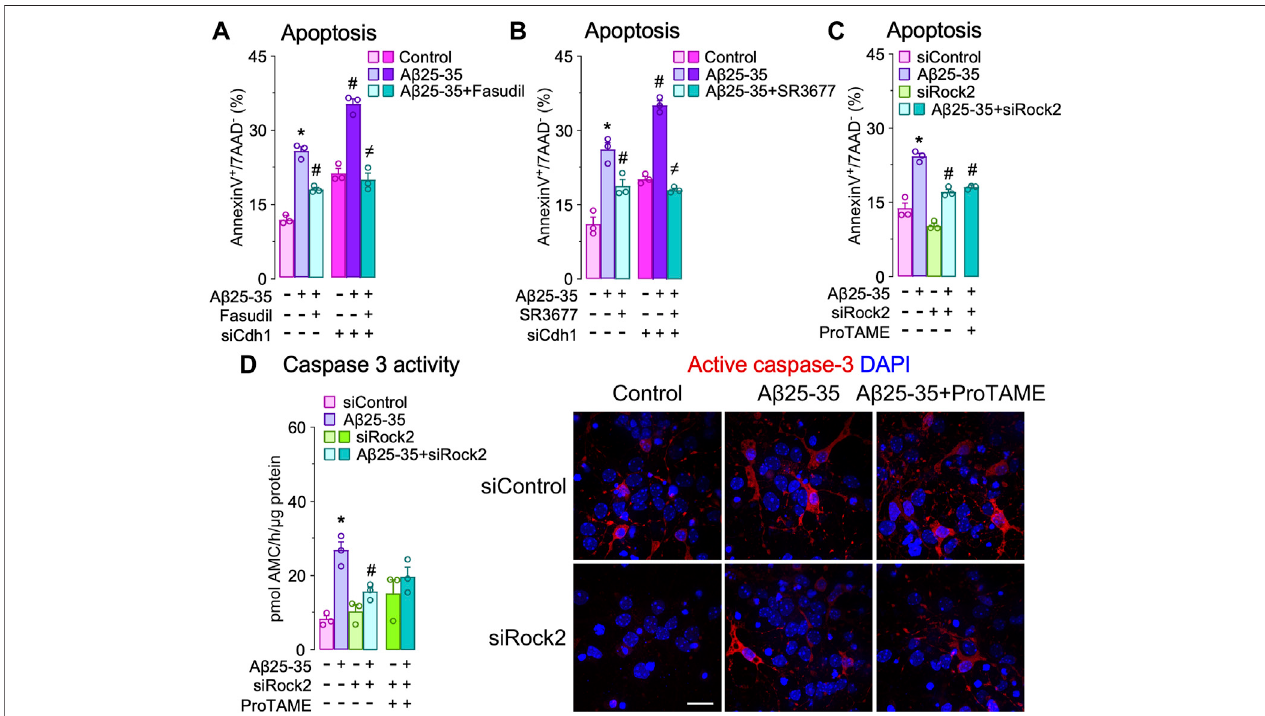
FIGURE 4 | Cdh1-induced Rock2 activation is involved in amyloid- β (A β ) neurotoxicity. Primary cortical neurons were incubated in culture medium in the absence (control) or the presence of oligomerized A β 25-35 (10 μ M). When indicated, medium was supplemented with fasudil (10 µM), Rock2 inhibitor SR3677 (10 µM) or ProTAME(10 µM). (A,B) Neuronsonday6 invitro weretransfectedwithsiRNAcontrol(9 nM)orwithsiRNAagainstCdh1(siCdh1;9 nM)for2 daysandthentreatedwith oligomerized A β 25-35 and (A) fasudil or (B) SR3677. Neuronal apoptosis was analyzed in neurons at 24 h of incubation with A β 25-35 ( n = 3 neuronal cultures). (C,D) Neurons on day 6 in vitro were transfected with siRNA control (9 nM) or with siRNA against Rock2 (siRock2; 9 nM) for 2 days and then treated with A β 25-35 oligomerized and ProTAME. (C) Neuronal apoptosis and (D) caspase-3 activity were analyzed in neurons at 24 h of incubation with A β 25-35 ( n = 3 neuronal cultures). Active caspase-3 immunocytochemical analysis in neurons treated with A β 25-35 and ProTAME for 24 h. Data are mean ± SEM for the indicated number of neuronal cultures. * p < 0.05 versus control; # p < 0.05 versus A β 25-35; ≠ p < 0.05 versus A β 25-35 + ProTAME.